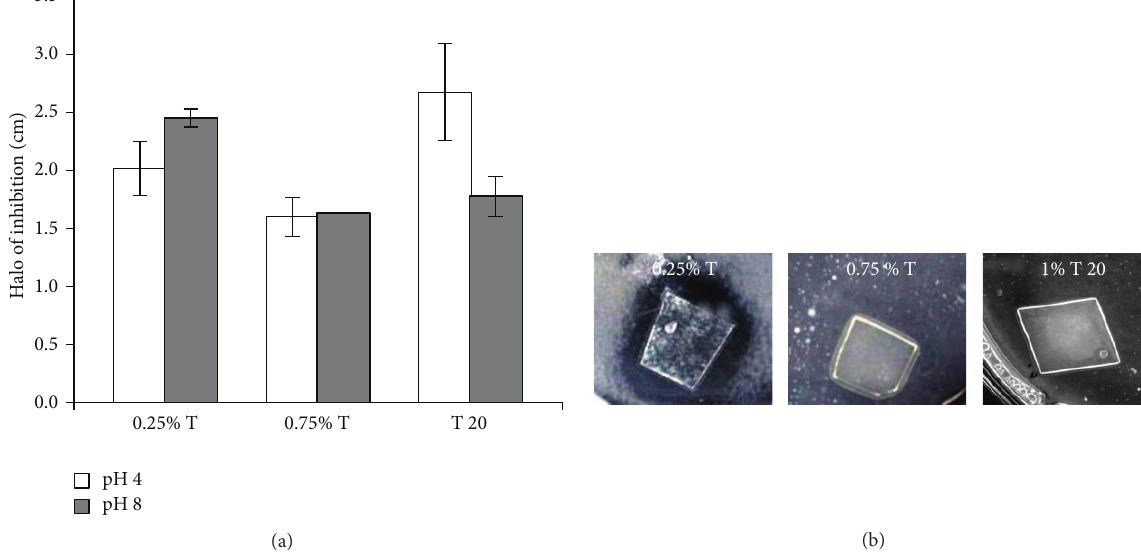
Figure 4: Halo of inhibition of the films against Escherichia coli by agar diffusion method. (a) Measurements. Bars correspond to standard deviation of mean value of triplicates. 0.25% T: 0.25% w/w trehalose; 0.75% T: 0.75% w/w trehalose; T 20: 1%w/w Tween 20. (b) Images of halo of inhibition as example.